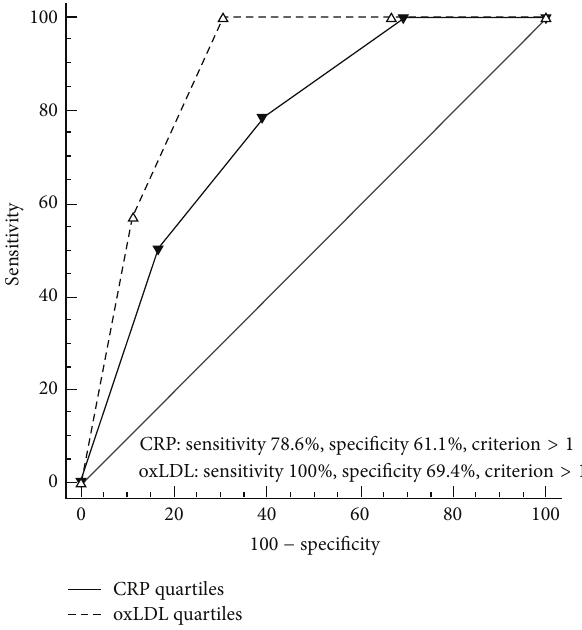
Figure 2: Receiver-operator characteristic (ROC) curves for the predictive validity of unadjusted CRP and oxLDL (per quartile increase) in lone AF patients. 1st, 2nd, 3rd, and 4th quartiles of biomarkers, respectively: CRP: < 0.80mg/L; 0.80 to < 1.58mg/L; 1.58 to < 2.70 mg/L; ≥ 2.70 mg/L; oxLDL: < 49.5 U/L; 49.5 to < 61.5 U/L; 61.5 to < 79.0 U/L; ≥ 79.0